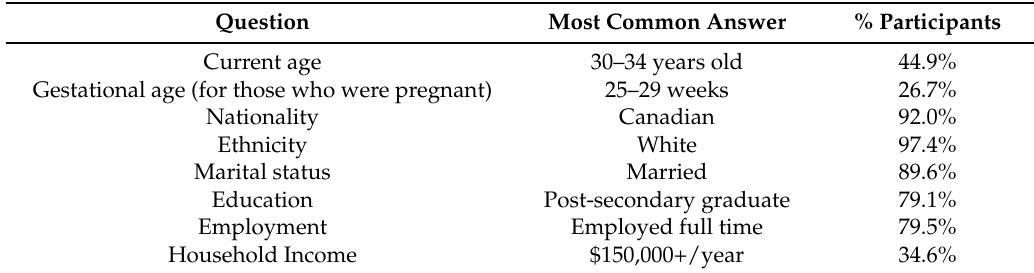
Table 2. The most common reported